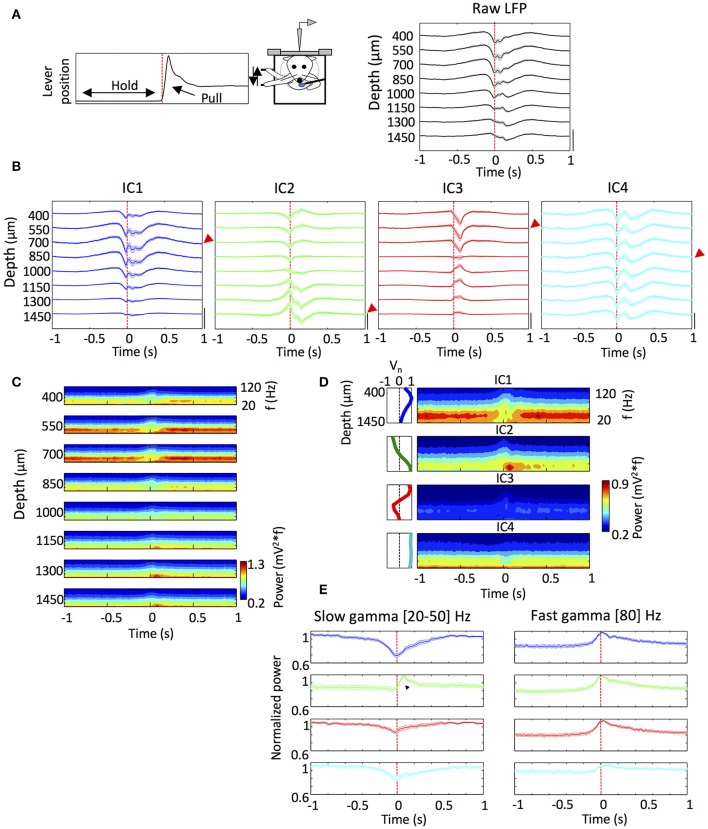
The ICs exhibited different dynamics during the performing of a reward motivated motor task. (A) Scheme of the head restrained rats performing the reward motivated forelimb movement task and a representative average of the lever position from an animal indicating hold and pull periods (Top) and mean of the lever pull onset-triggered average of the raw LFP (averaged from 1,200 to 2,000 trials in each rat) (Bottom). n = 10. (B) Same as (A) but for the reconstructed LFP for each IC. The red arrows indicate the electrode with the maximum amplitude in absolute values for each IC that was used below (See section Materials and Methods). n = 10. Amplitude calibration in (A,B): raw LFP, 1 mV; ICs, 0.5 mV. n = 10 rats. (C) Pull onset-triggered average of the Wavelet power spectrum of the raw LFP at different depths from a representative animal. (D) Same as (C) but for the ICs from the same animal. Inset: scheme of the voltage loading of each IC. (E) Time evolution of the slow gamma (20–50 Hz) and fast gamma (80 Hz) powers of the ICs around the lever pull onset. The traces correspond to the power of the wavelet power spectrum for a given frequency (between 20 and 50 Hz) where the IC exhibited a maximum in the power. The values of the frequencies at which each IC had a maximum differed between ICs (see section Results). The black triangle shows the sharp slow gamma power increase of the IC2 after the pull onset. Fast gamma powers were measured at 80 Hz for each IC. n = 10 rats. In all the panels the time 0 and the dashed red line mark the lever pull onset.